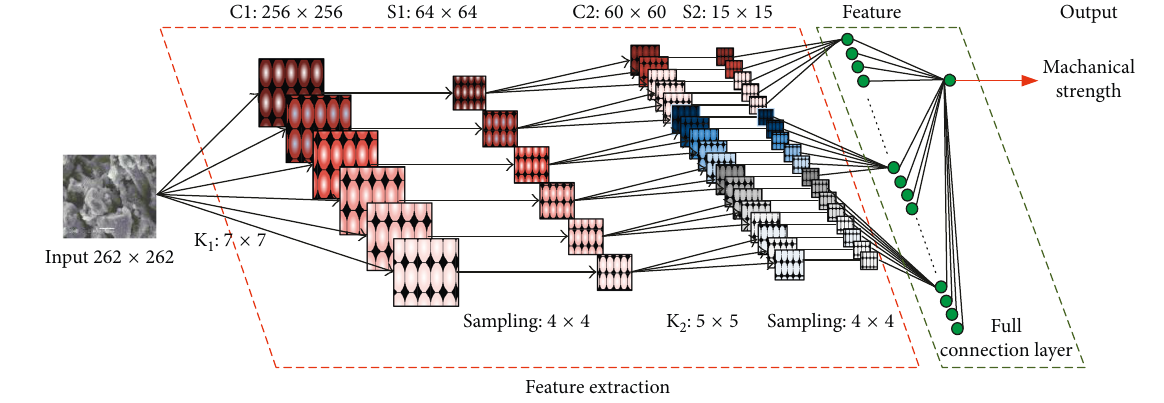
Figure 5: CNN structure diagram. Table 4: Comparison of the mechanical strength tested values and predicted